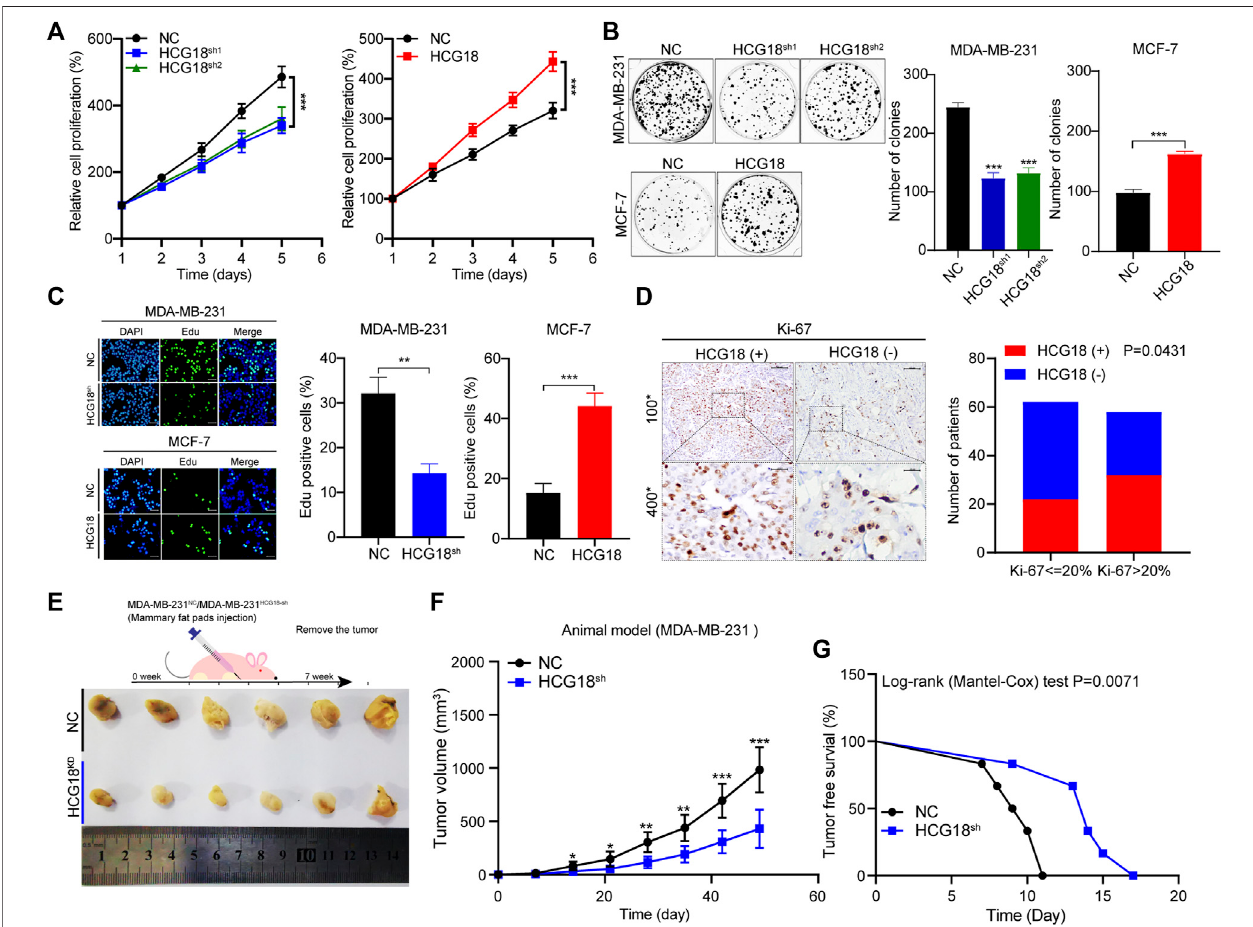
FIGURE 2 | (A , B) CCK-8 (A) and colony formation assays (B) were performed to detect the proliferation ability of MDA-MB-231 NC /MDA-MB-231 HCG18-sh and MCF-7 NC /MCF-7 HCG18 cells. (C) EdU staining assays showed that HCG18 promoted BC cell proliferation in vitro (scale bar, 50 μ m). (D) The expression level of Ki-67 in BCpatientswasdetectedbyIHC(upper:magni fi cation × 100;scalebar,100 μ m;lower:magni fi cation × 400;scalebar,20 μ m),andthecorrelationbetweenHCG18and Ki-67wasanalyzedbya χ 2 test(Ki-67 < 20%wasregardedaslowexpression). (E – G) MousexenograftmodelswereusedtoinvestigatethetumorigenesisofMDA- MB-231 NC /MDA-MB-231 HCG18-sh cells in vivo (E) ; the volumes of tumors were recorded (F) , and the tumor-free survival of the two groups was analyzed (G) . The data are shown as the mean ± SD. * p < 0.05, ** p < 0.01, *** p < 0.001. The data represent at least three independent